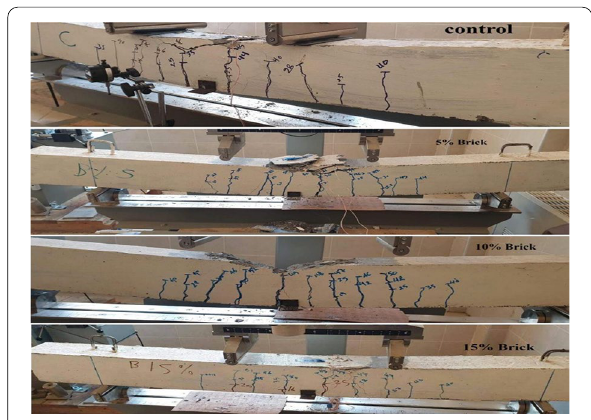
Fig. 16 Failure mode of beams containing crumbed rubber.